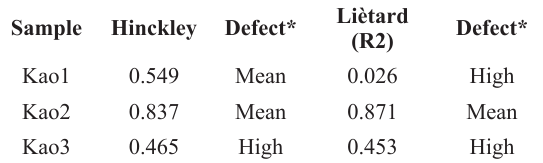
Crystallinity index of Kao1, and Kao2